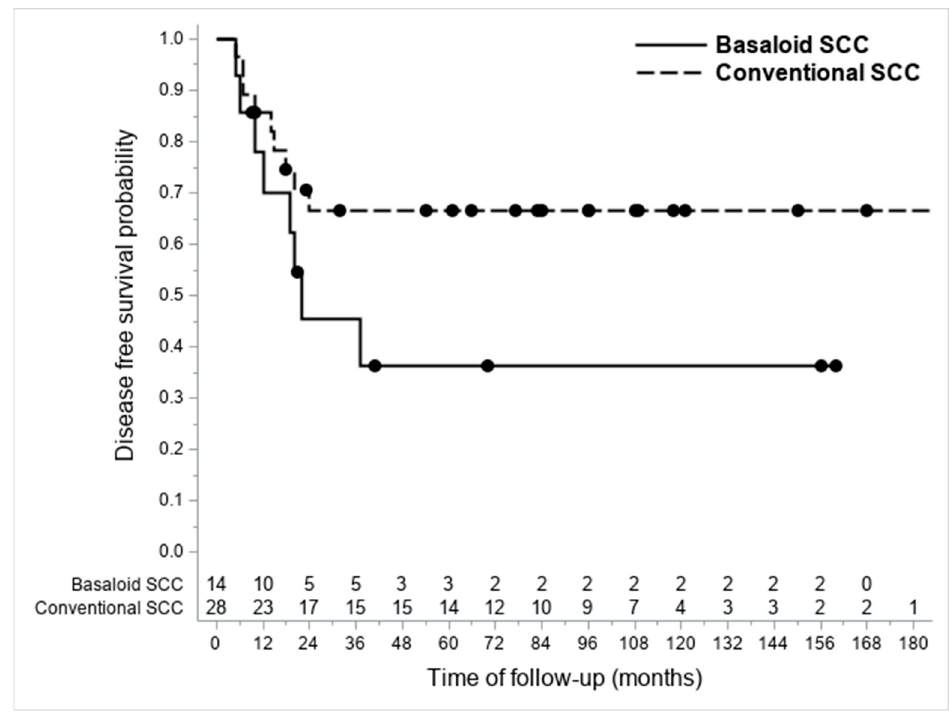
Figure 4. Kaplan-Meier graph showing differences in DFS between considered BSCCs and conventional SCCs. Table 2. Univariate Cox’s regression model based on the histotype. Outcome